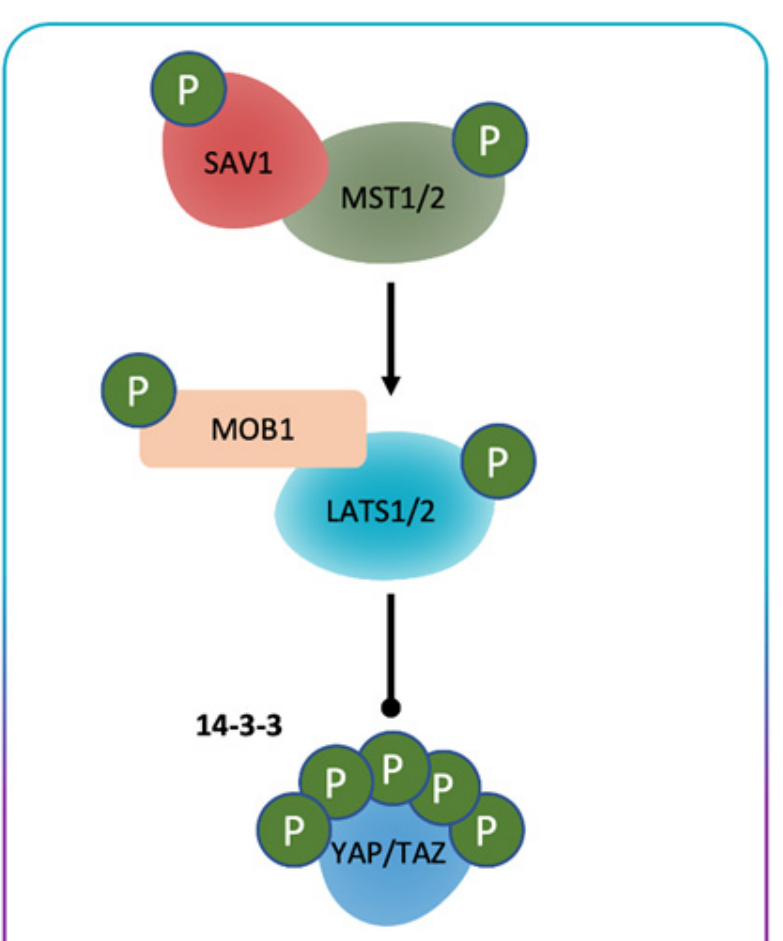
Figure 1. Overview of the Hippo signaling pathway. Hippo signaling is initiated by a variety of upstream stimuli. Activation of Hippo (MST1/2) leads to subsequent phosphorylation of LATS1/2. LATS1/2 negatively regulates the Hippo pathway effector YAP/TAZ. Unphosphorylated YAP/TAZ translocates into the nucleus where it interacts with TEAD transcription factors to upregulate the transcription of a variety of genes. In contrast, phosphorylation of YAP/TAZ leads to its cytoplasmic sequestration by 14-3-3 proteins and degradation.